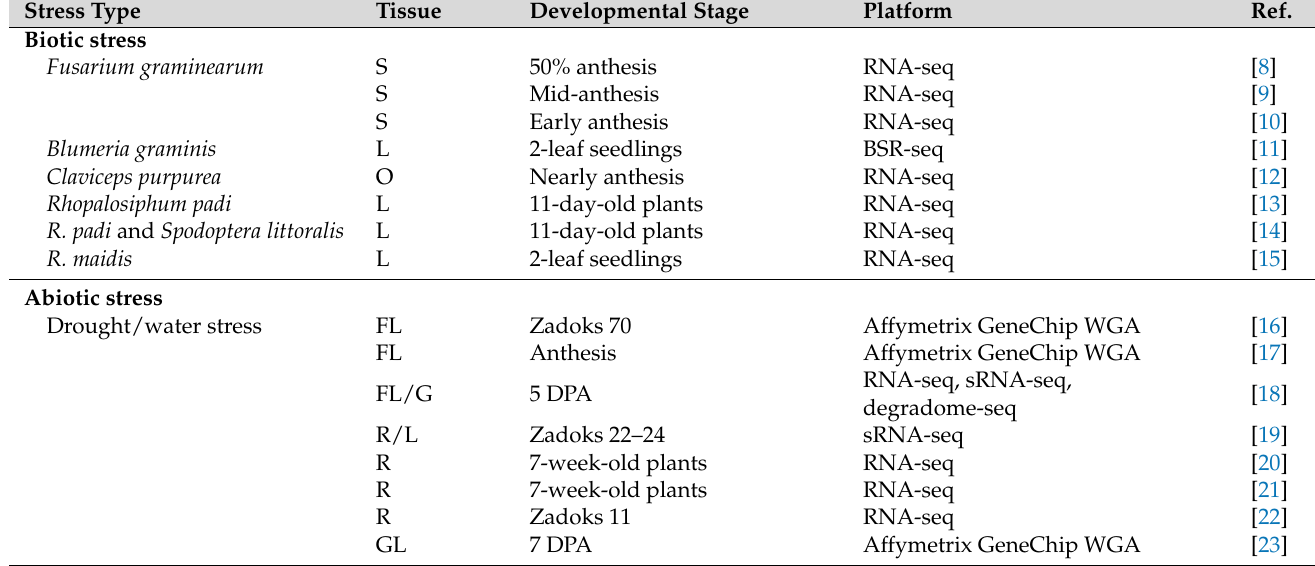
Early anthesis RNA-seq Blumeria graminis L 2-leaf seedlings BSR-seq O Nearly anthesis RNA-seq